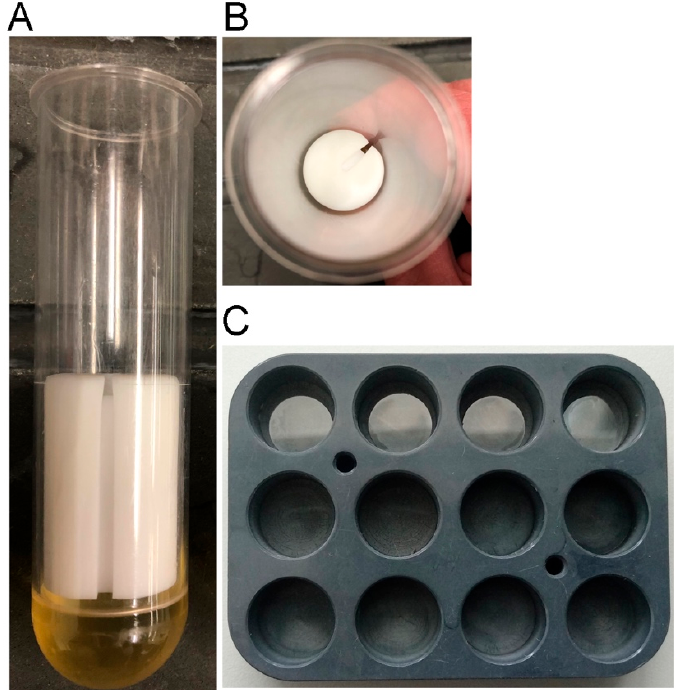
Figure 1. Centrifugation devices. Panel ( A ) shows a side view, panel ( B ) shows a top down view of a 50 mL Sorvall centrifugation tube fitted with an EPON base (yellow layer in A ) and a white Delrin rod segment (2.5 cm diameter, 3.75 cm length). The notch along the side is helpful to retrieve coverslips with forceps, allowing access to the underside of the coverslip for lifting. Panel ( C ) shows a modified multiwell holder for processing up to 12 samples at a time. The top row contains 12 mm round coverslips; these can be readily removed with curved forceps.